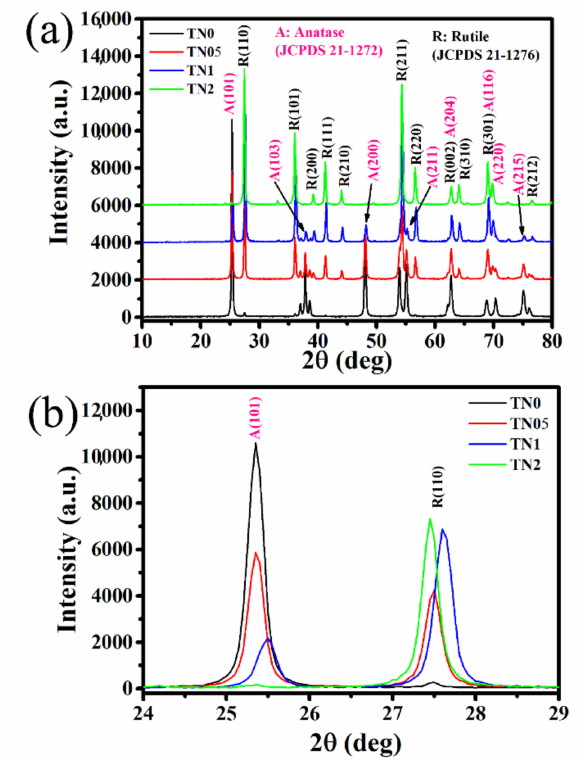
Figure 1. ( a ) Powder XRD patterns of undoped and Ni-doped TiO 2 , ( b ) zoom in on main anatase and rutile peaks. Table 1. Lattice parameters, estimated phase composition and Brunauer–Emmet–Teller (BET) values of the co-precipitation synthesized undoped and all Ni-doped TiO 2